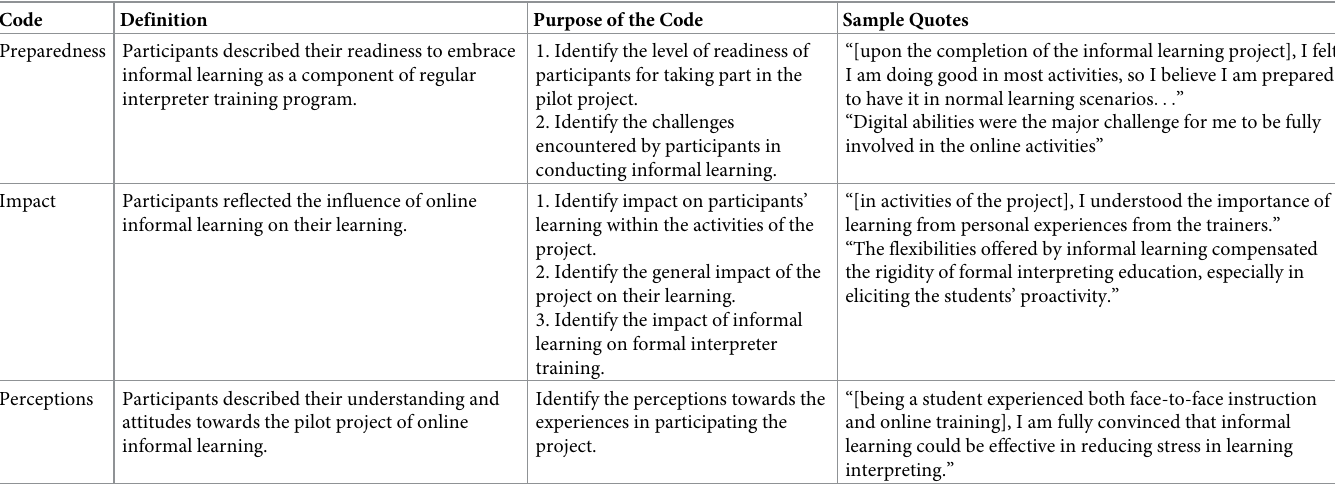
Table 4. Excerpted codebook from the qualitative analysis of